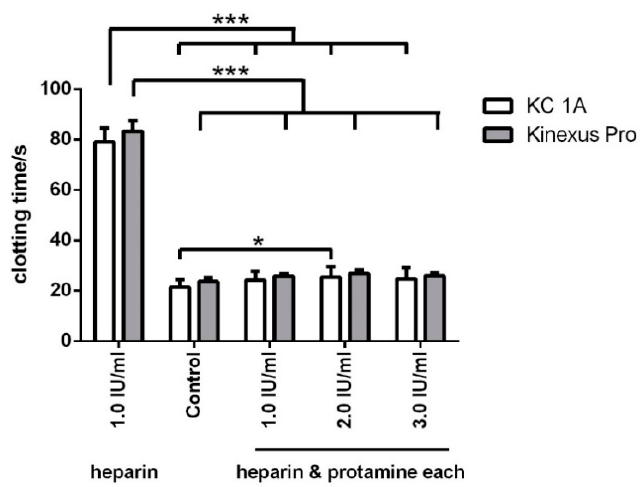
Figure A7. Clotting times (CT) of citrated blood with various heparin and the equimolar protamine concentrations activated with Thromborel ( n = 5). The asterics above the bars indicate that this particular bar is significantly different from all others. Comparing CTs measured with KC 1A and Kinexus Pro, there was no significant difference observed, i.e., the systems provided comparable results with the three heparin-protamine combinations. * p < 0.05, *** p < 0.001.